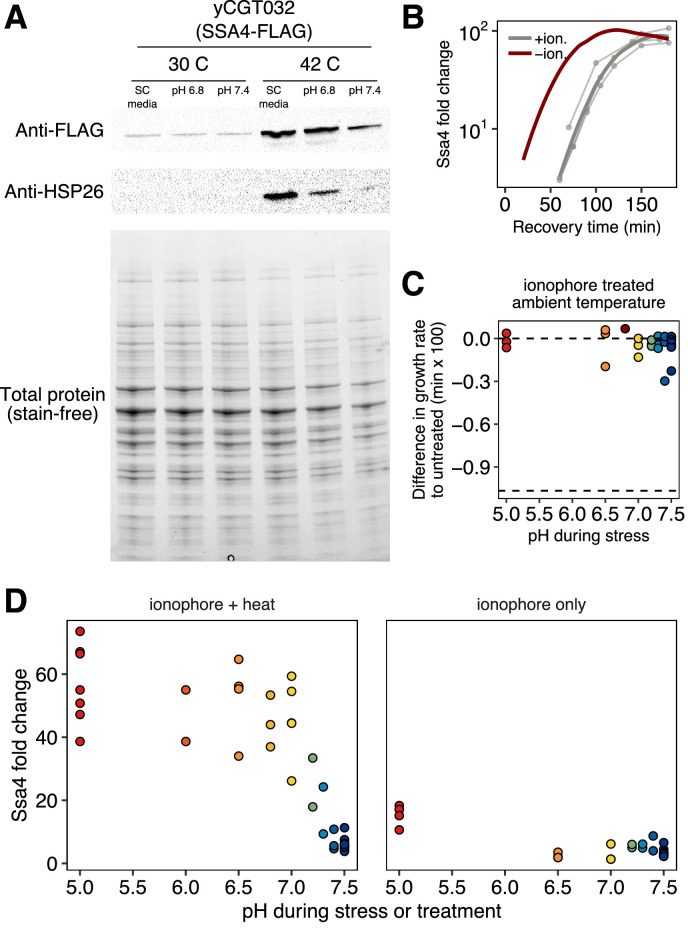
Western blot against Ssa4-mCherry and native Hsp26 after heat shock with and without acidification and stress protein production after acidification only.(A) Western blot and total protein gels for yeast carrying a the genomic copy of SSA4 tagged with a FLAG tag heat stressed with and without ionophore treatment, as described in Growth Conditions in the Materials and methods section. Samples were taken 1 hr after stress. (B) Induction of Ssa4 during recovery from normal (red) or pH-manipulated (gray, pH 6.8) stress. Thin curves are individual experiments and thick curves are smoothed conditional means (see Materials and methods for details). The red curve is the same data from Figure 1D for comparison. Although pH manipulation causes a delay in Ssa4 production, it does not affect the ultimate level of induction. (C) Growth rate difference in cells treated with ionophore for 35 min at room temperature followed by return to ambient growth conditions. Competitor was untreated cells. The values cluster around zero, indicating little to no loss of fitness due to ionophore treatment. Bottom dashed line shows theoretical minimum of the growth rate difference, which would result if cells completely arrested growth. These data are the same as those in Figure 6B, light-colored points. (D) Comparison of Ssa4-mCherry induction in ionophore treated cells that were either heat stressed (left) or held at room temperature (right). Acidification artificially induced by ionophore treatment does not cause appreciable accumulation of stress protein.